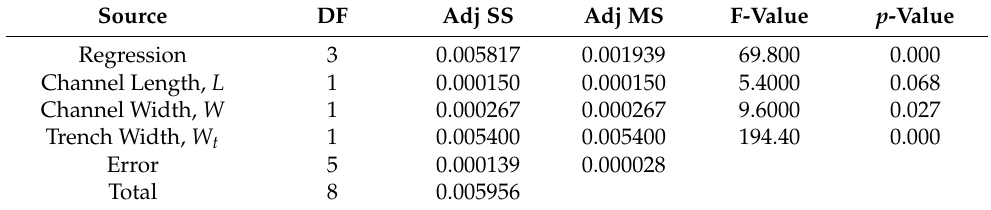
Table 12. Regression ANOVA for V